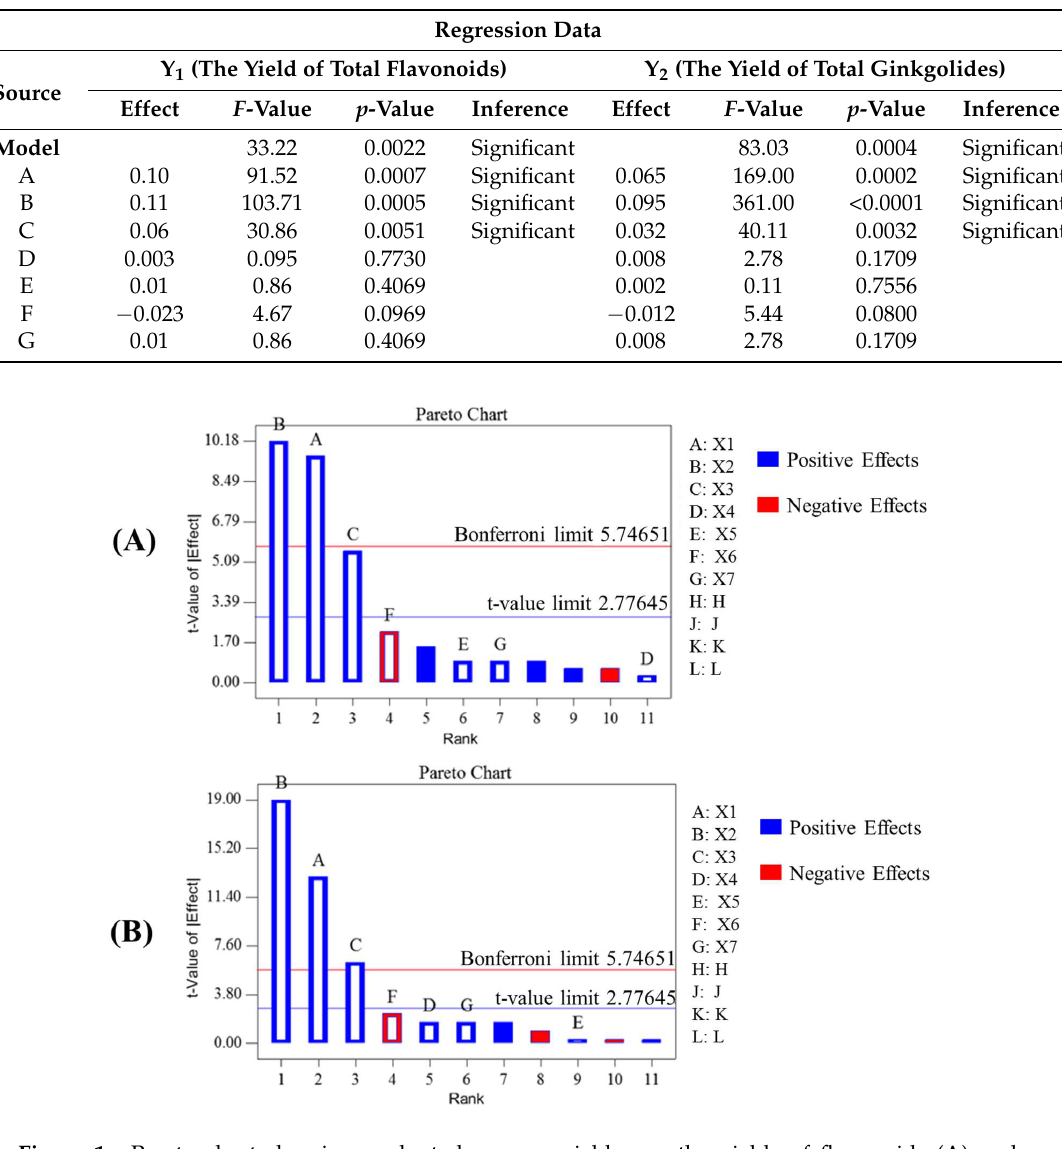
Figure 1. Pareto chart showing evaluated seven variables on the yields of flavonoids ( A ) and ginkgolides ( B ) from G. biloba fallen leaves. Variables with t-values higher than the critical value (2.776) were regarded as being statistically significant.